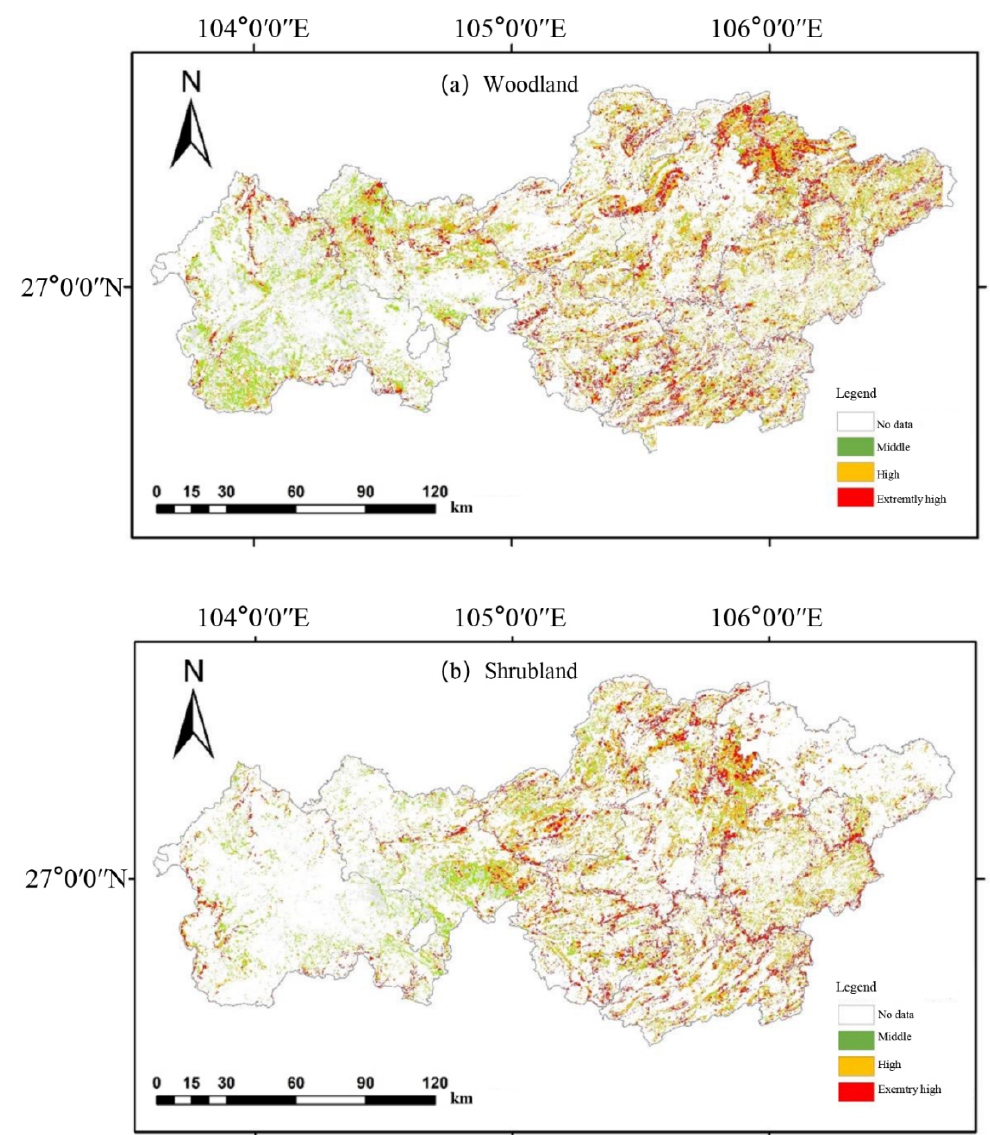
Figure 4. Spatial distribution map of landslide susceptibility in shrubland in Bijie City.